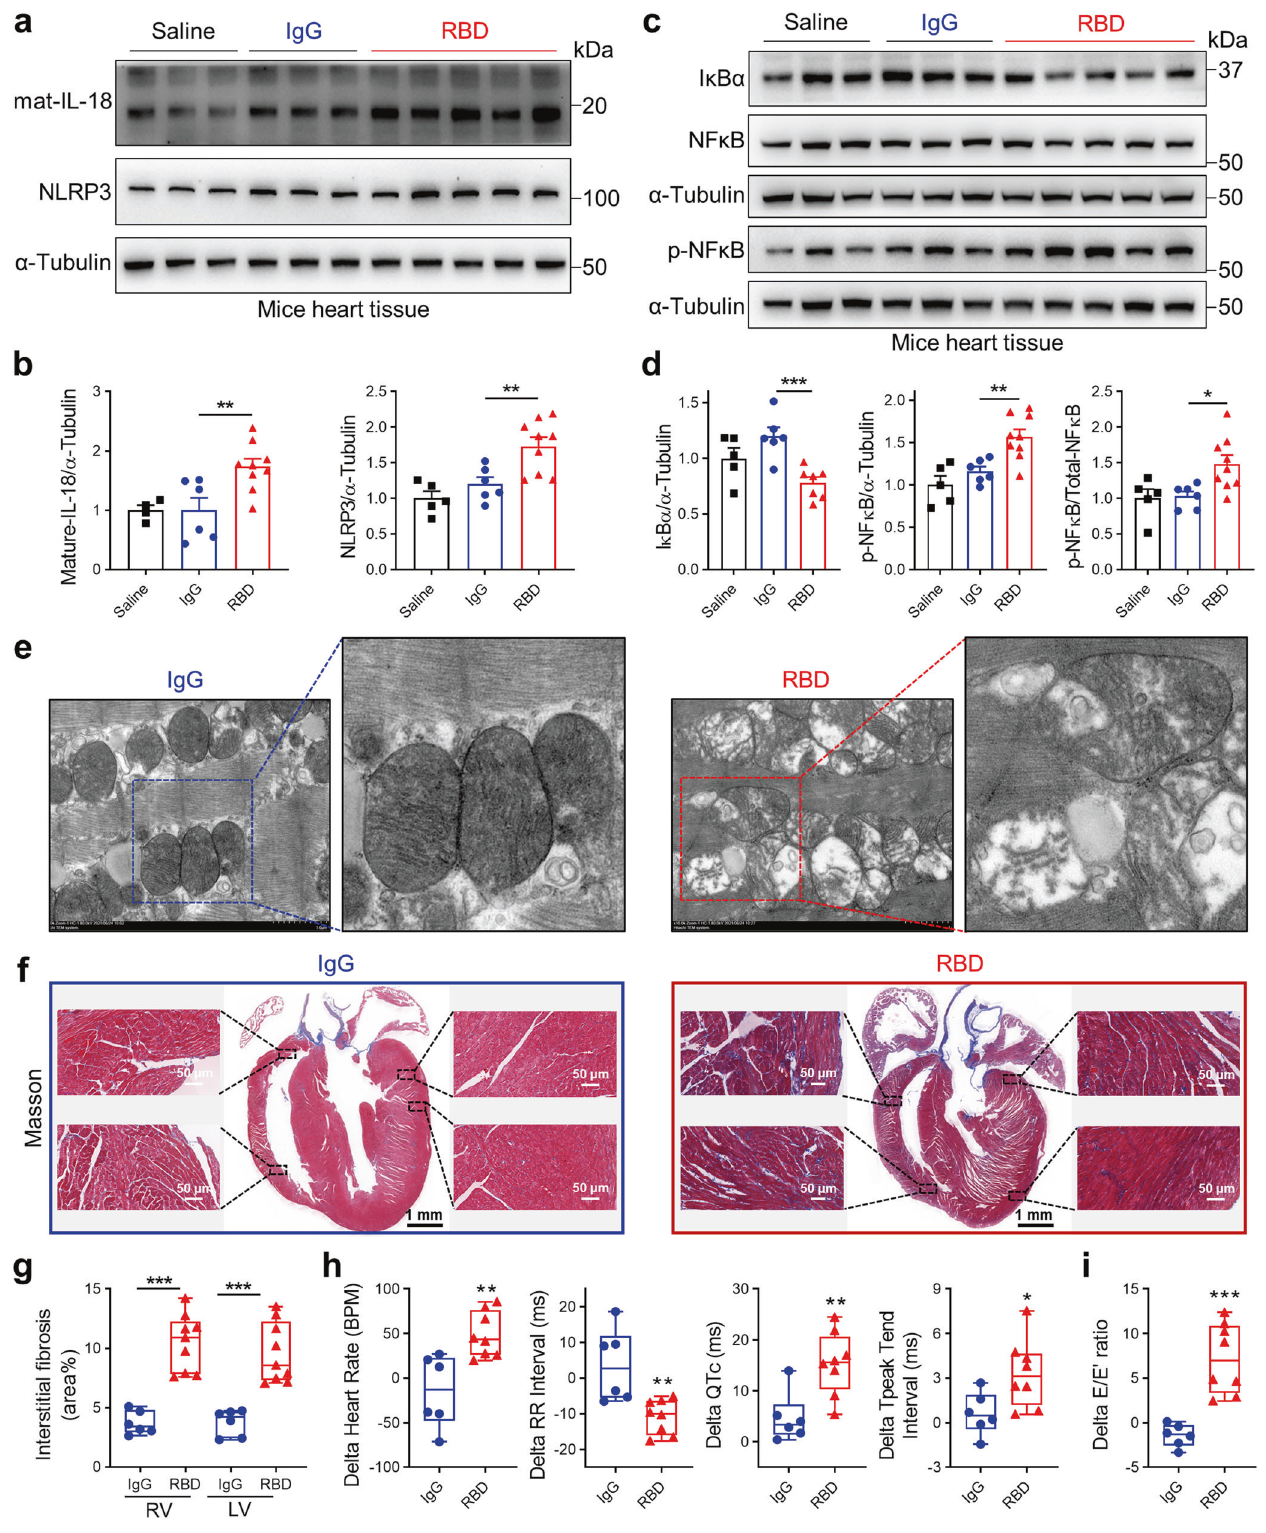
Fig. 4 Spike RBD protein induces cardiac IL-18 expression, fi brosis mitochondria injury, heart dysfunction in hACE2-KI mice. a , b Western blots of IL- 18 and NLRP3 levels in heart tissues. Quantitative data shown in panel below ( b ) (Student ’ s t -test, N = 5 – 9). Representative western blots showing I κ B α , NF- κ B, phospho-NF- κ B protein levels ( c ) and summarized data ( d ) in heart tissues (Student ’ s t -test, N = 5 – 9). e Representative images from transmission electron microscopy (TEM) after IgG and RBD treatment. f , g Representative Masson Trichrome staining images of heart from IgG- versus RBD protein-treated mice. Fibrosis area percentage was higher in RBD protein-treated mice heart tissues (Student ’ s t -test, N = 6 – 9). h Heart rate, RR interval, QTc interval, Tp-Te interval were measured by electrocardiograms (ECG) in mice after RBD exposure (Student ’ s t -test, N = 6 – 8). i Diastolic function was impaired (increased delta E / E ’ ) after RBD exposure (Student ’ s t -test, N = 6 – 8). Values are mean ±SE. * p <0.05, ** p <0.01, *** p <0.001